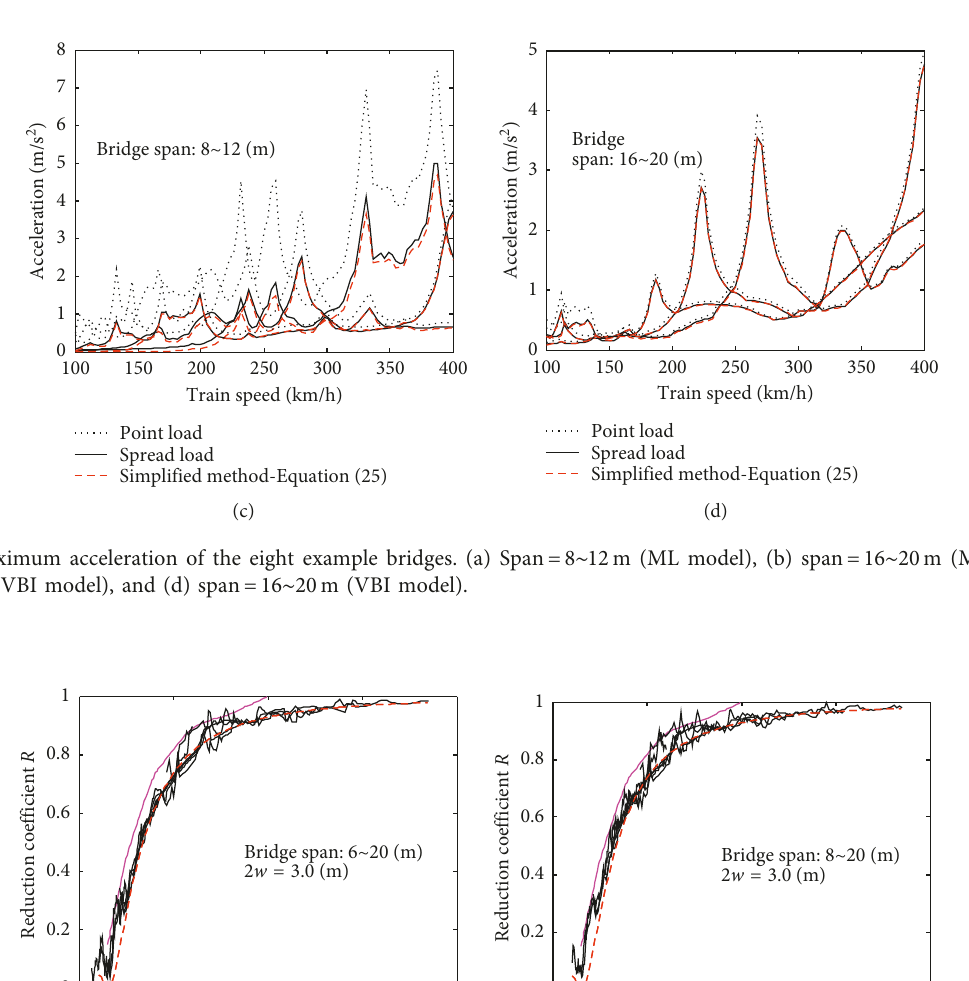
16 ∼ 20 m (VBI model). (cid:29)